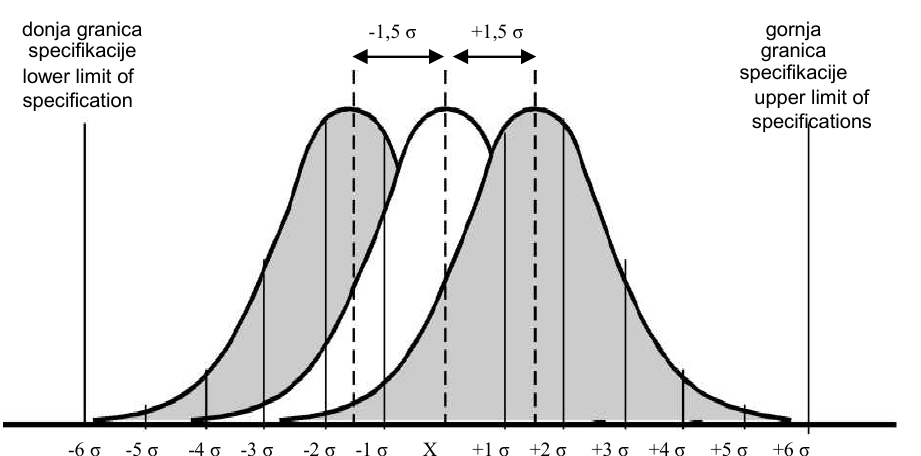
Figure 3 – Dissipation of the process and the shift of the dissipation center Рис . 3 – Рассеивание процессов и перемещение центра рассеивания Slika 3 – Rasipanje procesa i pomeranje centra